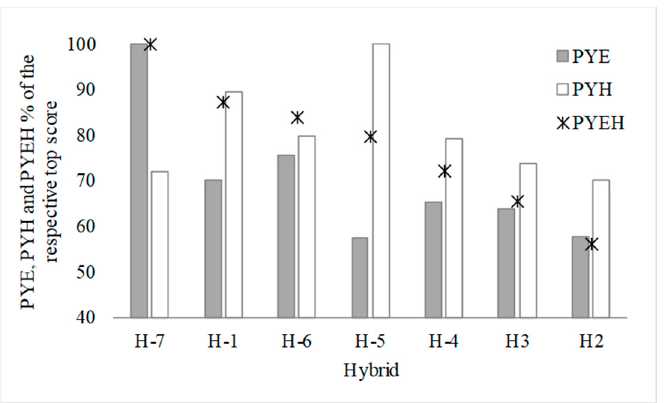
Figure 1. Scores of seven hybrids for the relative plant yield efficiency (PYE), plant yield homeostasis (PYH) and plant yield efficiency by homeostasis (PYEH), all expressed % of the respective top score. (Hybrids arranged on descending order for PYEH). Ж PYEH